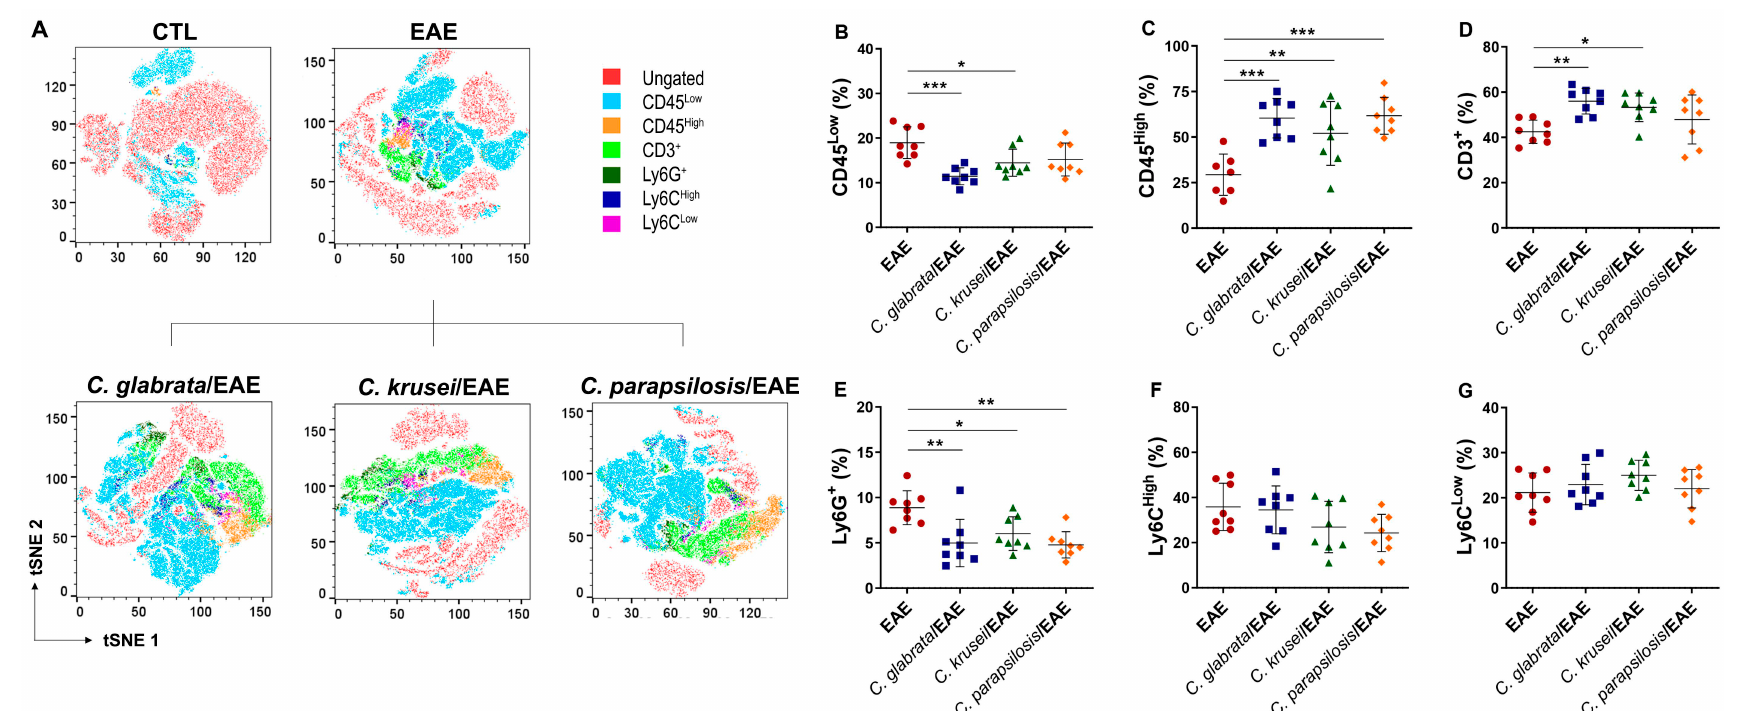
Figure 6. Leukocyte infiltration in the CNS of infected EAE mice. Mononuclear cells eluted from the CNS of mice with EAE were stained with anti-mouse fluorochrome conjugated monoclonal antibodies and analyzed by flow cytometry through t-distributed stochastic neighbor embedding (tSNE) plots ( A ). Percentage of CD45 Low ( B ), CD45 High ( C ), CD3 + gated on CD45 High Ly6G - ( D ), Ly6G + gated on CD45 High ( E ), Ly6C High gated on CD45 High Ly6G − CD11b + ( F ), and Ly6C Low gated on CD45 High Ly6G − CD11b + ( G ) cells. The results are expressed as mean ± SD from two independent experiments (n = 8/group) and * p < 0.05, ** p < 0.01, and *** p <